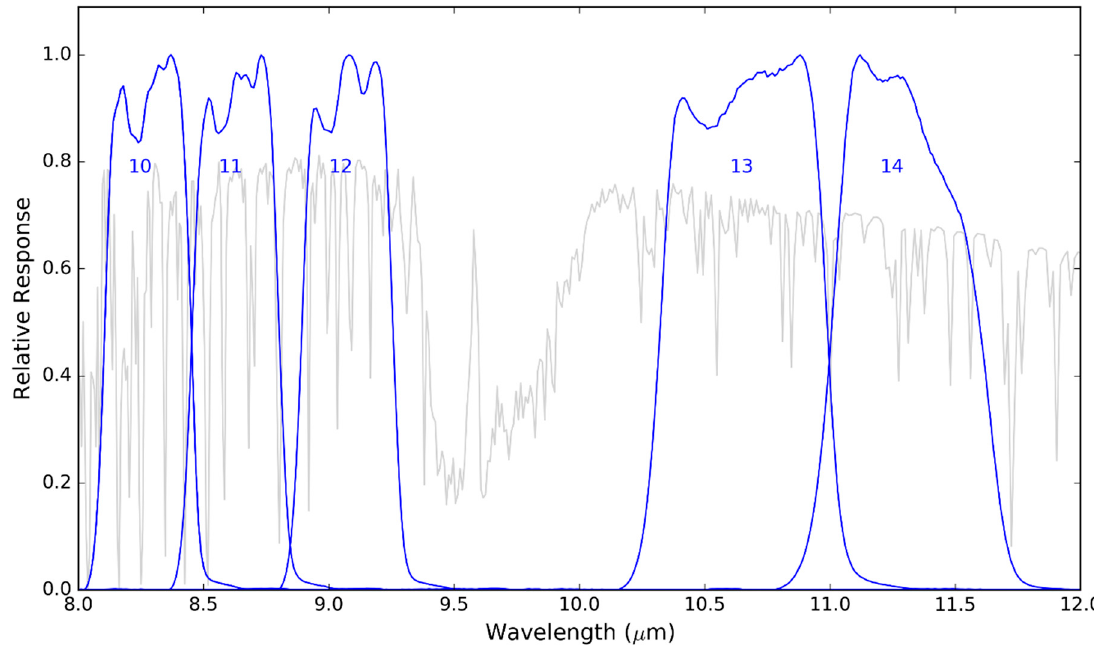
Figure 12. Spectral response functions of ASTER Bands 10–14 (blue) and the atmospheric transmittance of a mid-latitude summer atmosphere calculated using MODTRAN 5 (grey) [48].